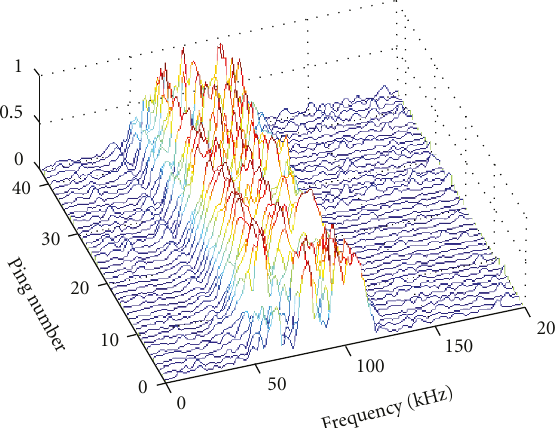
Figure 12: Waterfall plot of the cable echo spectra whilst the general three-lobed pattern distinctive for this cable/pulse combination is strongly in evidence, variations would make discrimination from a single ping highly di ffi cult and a more reliable detector will be built by integrating over sequences of returns.